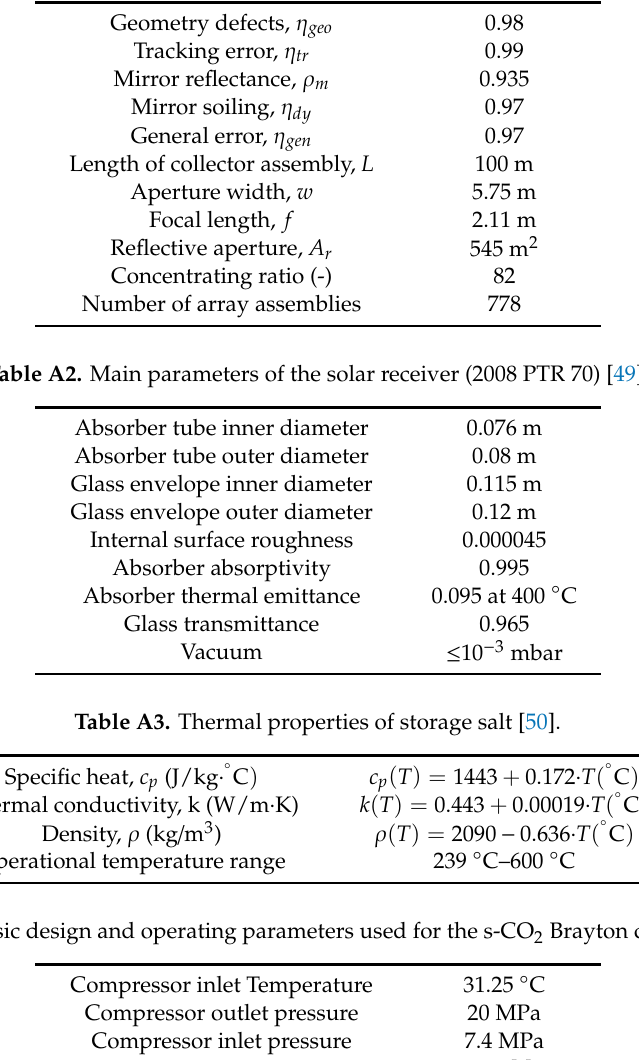
Table A1. Main parameters of the solar concentrator [48].